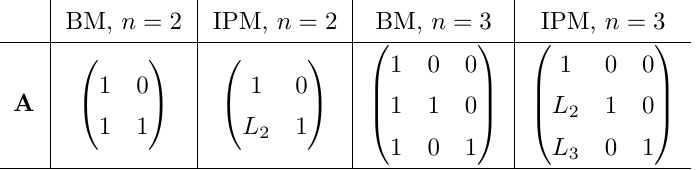
for BM and IPM, 2 8